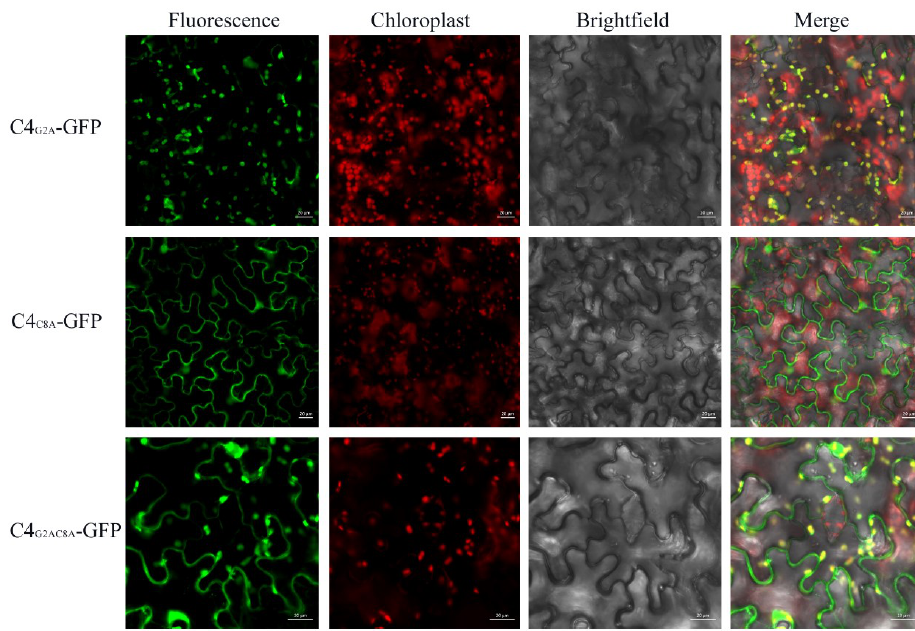
Figure 5. Subcellular localization of AGV C4 mutant variants on N-terminal acylated sites in N. benthamiana leaves. The recombinant fluorescent protein C4 G2A -GFP expressed from pCam35S-C4 G2A -GFP is mainly localized to chloroplasts, C4 C8A -GFP expressed from pCam35S-C4 C8A -GFP is targeted to plasma membrane, and nucleus and C4 G2AC8A -GFP expressed from pCam35S-C4 G2AC8A -GFP is localized in the cytoplasm, nucleus, and chloroplasts. The chloroplasts are identified by the red auto-fluorescence of chlorophyll. Confocal laser scanning images were taken approximately 3 d post infiltration. Scale bars indicated in the photos represent 20 µ